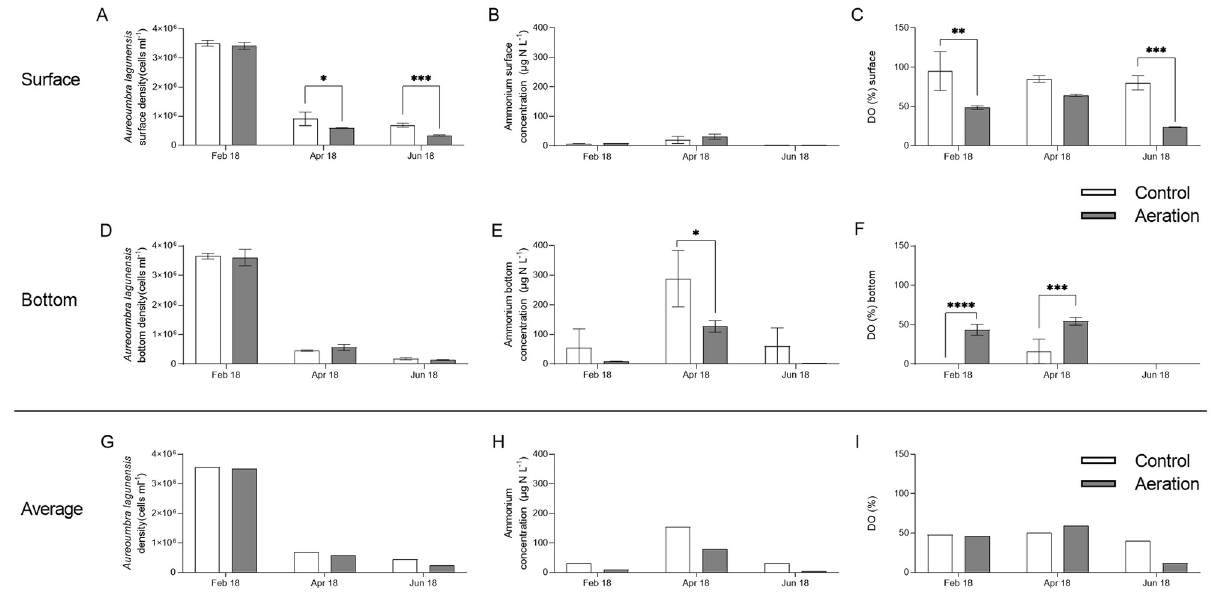
Fig 3. Surface water (A) Aureoumbra lagunensis cell densities, (B) ammonium concentrations and (C) DO (%) in control vs. aeration canals from February to June 2018. Bottom water (D) A . lagunensis cell densities, (E) ammonium concentrations and (F) DO (%) in control vs. aeration canals from February to June 2018. Average (G) A . lagunensis cell densities, (H) ammonium concentrations and (I) DO (%) in control vs. aeration canals from February to June 2018. Different significance levels were determined via 2-way ANOVA and Fisher’s LSD post-hoc pairwise comparisons ( � p < 0.05, �� p < 0.01, ��� p < 0.001, ���� p <